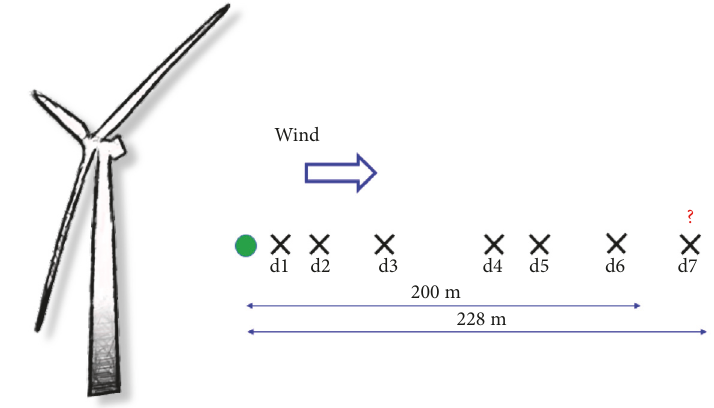
Figure 11: Measurements upstream the wind turbine in the LiDAR experimental campaign. Data are available in the six planes that are closer to the wind turbine, while the data on the seventh plane are to be